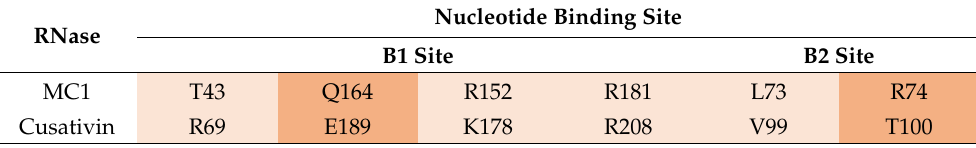
Table 2. Comparison of nucleobase binding site amino acid residues in RNase MC1 and cusativin. Substitutions in dark orange cells indicate significant changes in interactions, those in light orange cells do not show significant changes in interactions and those highlighted in yellow does not show interactions with the